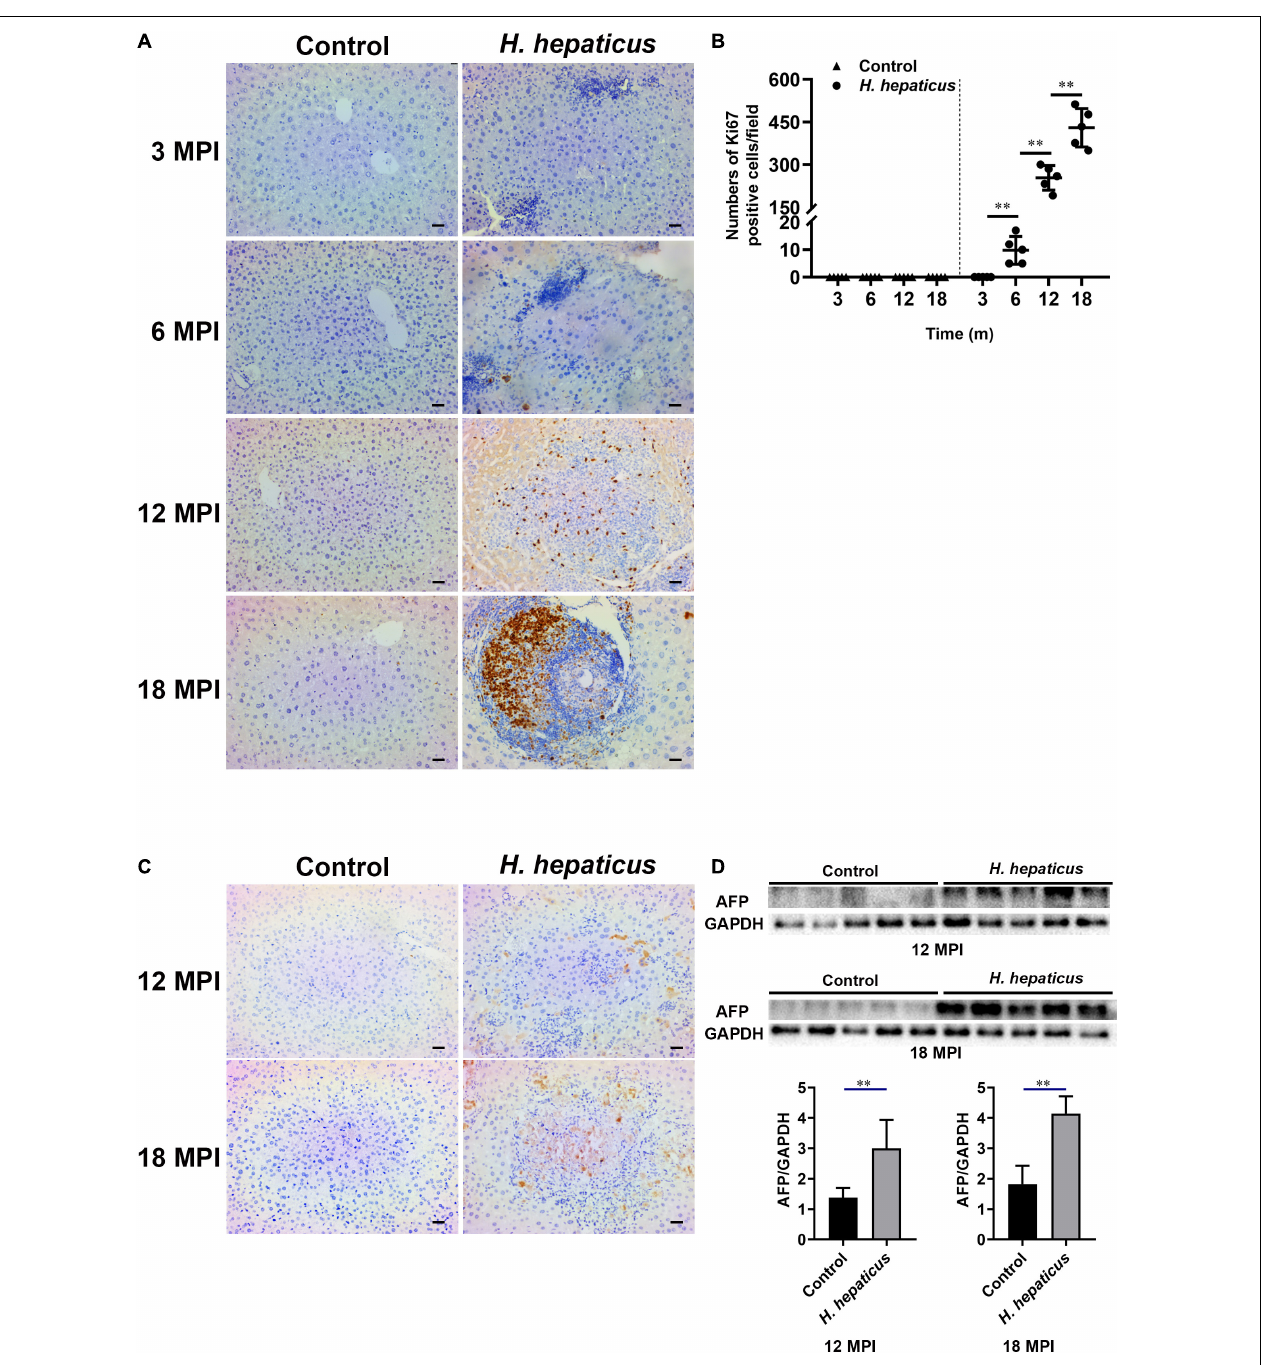
FIGURE 5 | Helicobacter hepaticus infection induced cell proliferation and hepatic preneoplasia. (A) Immumohistochemical (IHC) staining of Ki67 images of the liver in H. hepaticus –infected and control mice at all time points (magnification, × 200). (B) The number of Ki67-positive cells was calculated and compared. Data are expressed as the means ± SD ( n = 5). (C) Immumohistochemical (IHC) staining of AFP images of the liver in H. hepaticus –infected and control mice at 12 and 18 MPI (magnification, × 200). (D) Western blot and densitometric analysis of AFP and GAPDH of the liver in H. hepaticus –infected and control mice at 12 and 18 MPI. ∗∗ p < 0.01 as compared to the control. Each group contained five